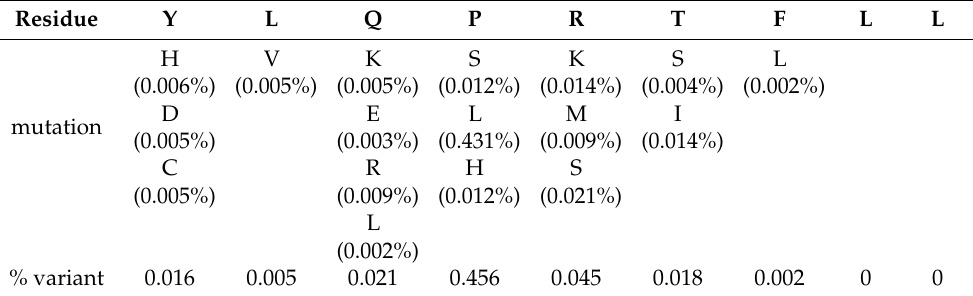
Table 2. YLQ conservation in SARS-CoV-2 isolates (non-synonymous mutation).